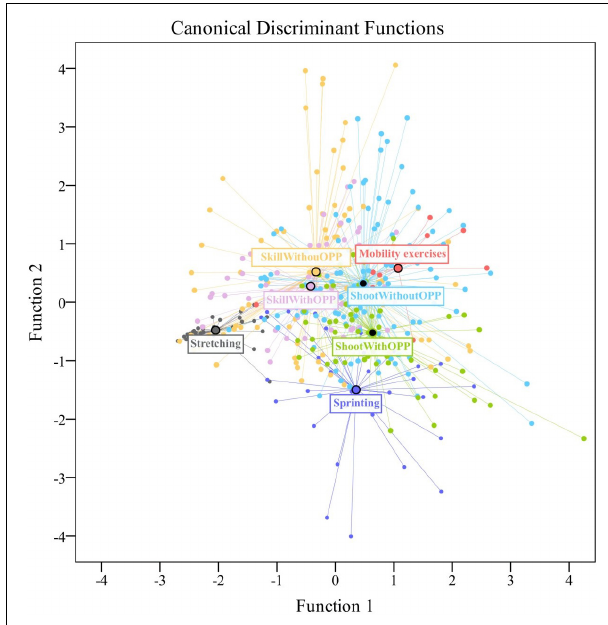
FIGURE 3 | Territorial map of discriminant functions for the task categories of the elite warm-up.